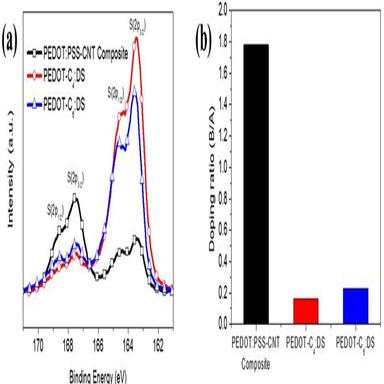
S(2p) XPS spectra (a) and doping ratio (B/A) (b) of PEDOT:PSS-CNT composite, PEDOT-C4:DS, and PEDOT-C6:DS (A: PEDOT derivatives, B: Dopants).